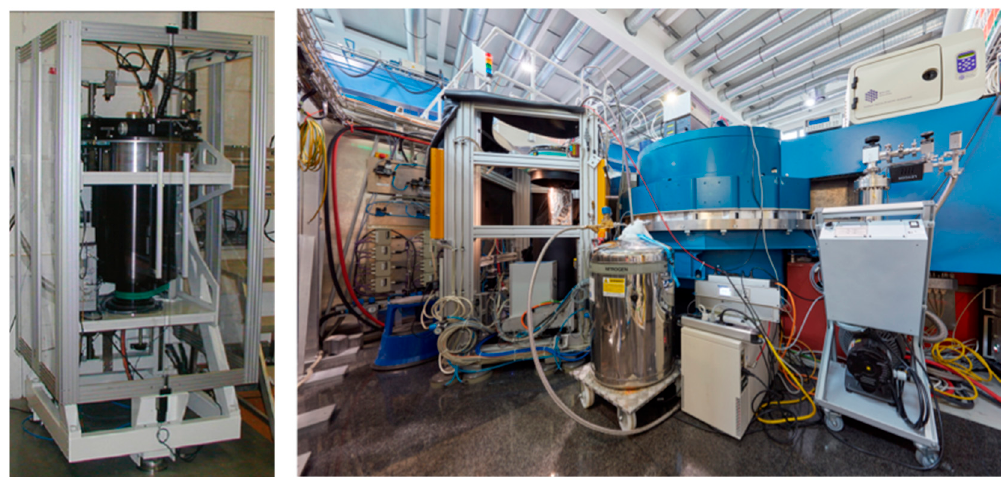
Figure 1. Neutron protein crystallography instrumentation. ( Left ) photograph of the LADI-III Quasi-Laue diffractometer, located at the Institut Laue-Langevin, Grenoble FR [19]; ( Right ) photograph of the BIODIFF monochromatic diffractometer, located at Heinz Maier-Leibnitz Zentrum, Munich DE. Re-used with permission from the photographer, Bernhard Ludewig.